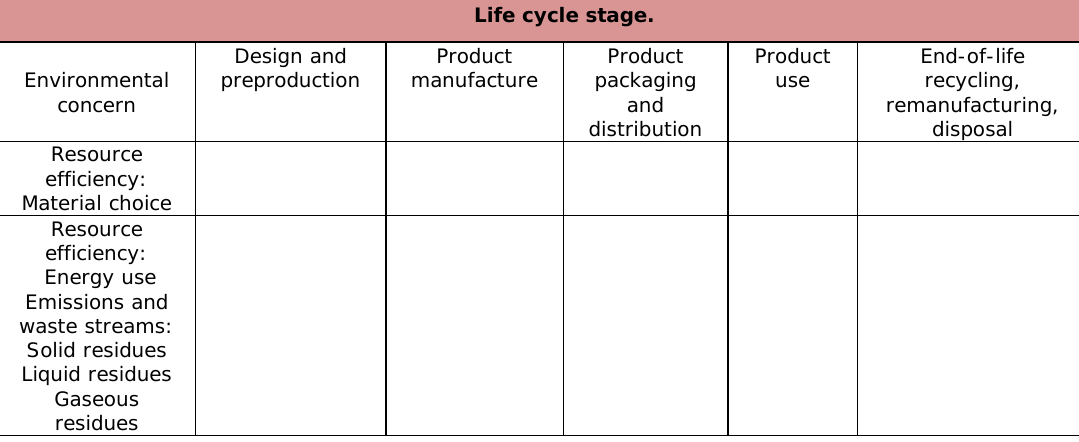
Figure 4. “Industrial ecology subset of typology”. Source: adapted from Allenby